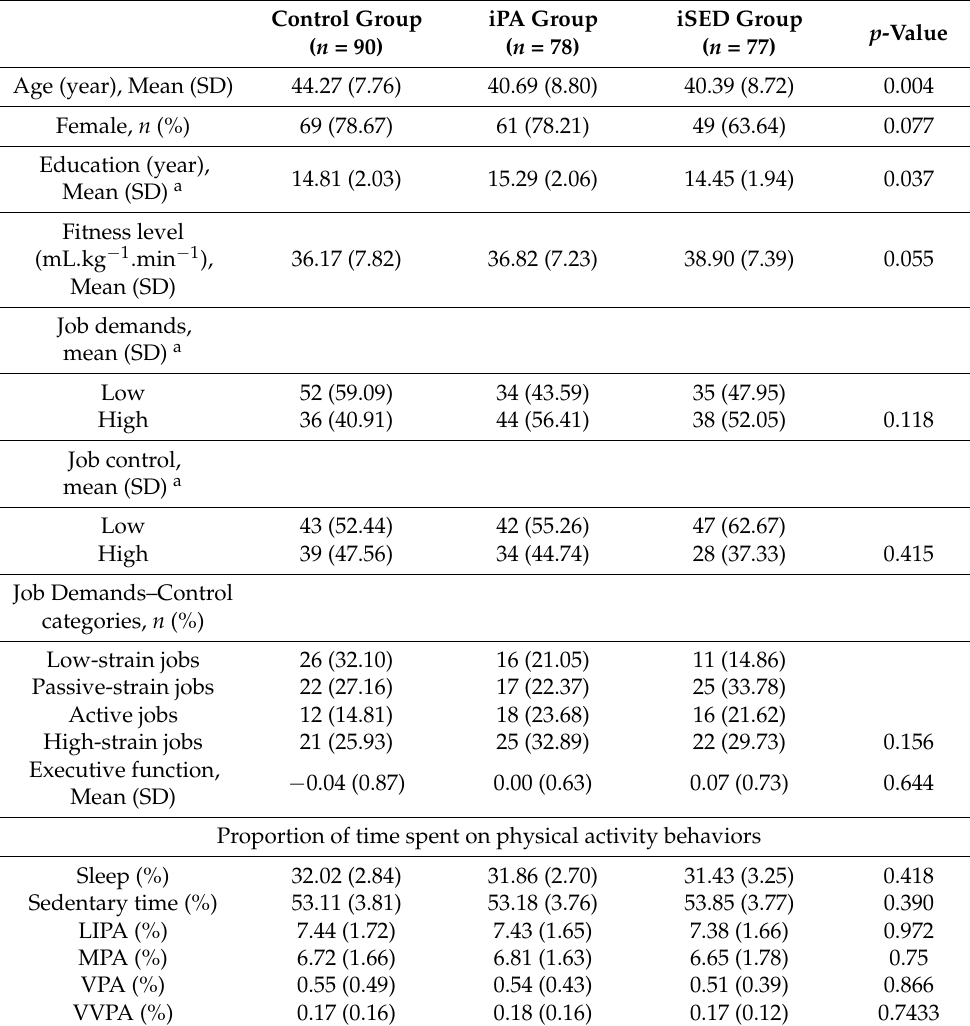
Table 2. Characteristics of participants at baseline ( n =